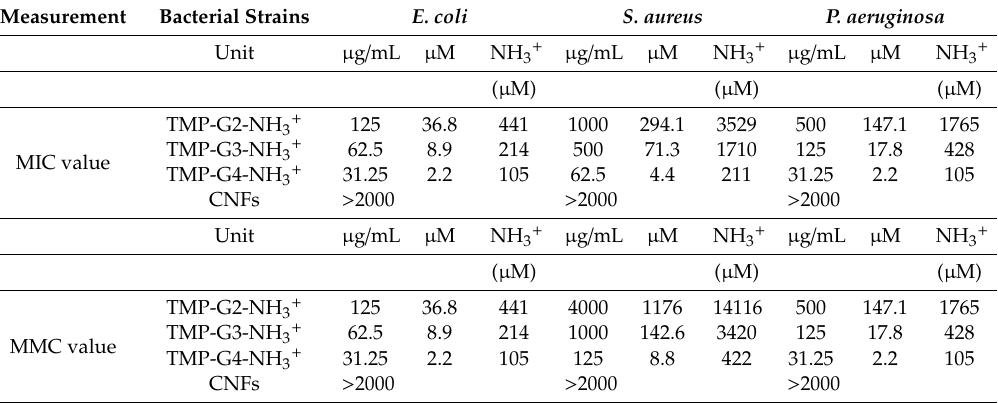
Table 2. Minimum inhibitory concentration (MIC) and minimum microbicidal concentration (MMC) values of the cationic dendrimers and CNFs.